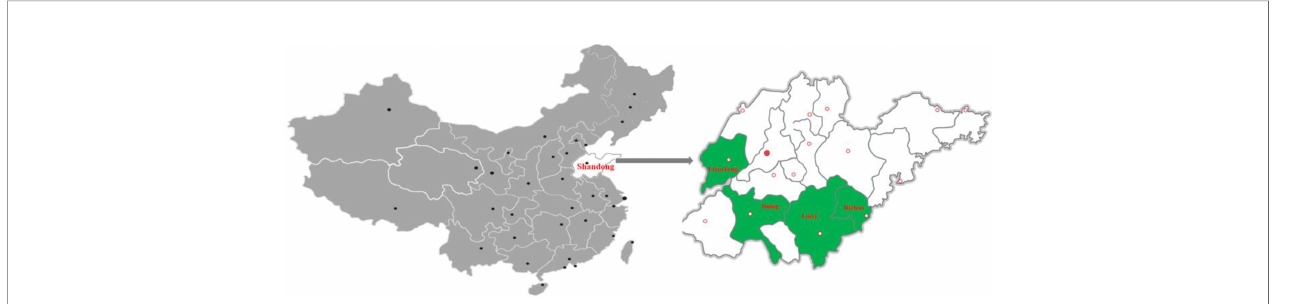
FIGURE 1 | A map of China showing the four cities, Jining, Linyi, Rizhao, and Liaocheng, in Shandong province, eastern China, where the serum and milk samples of the domestic donkeys were